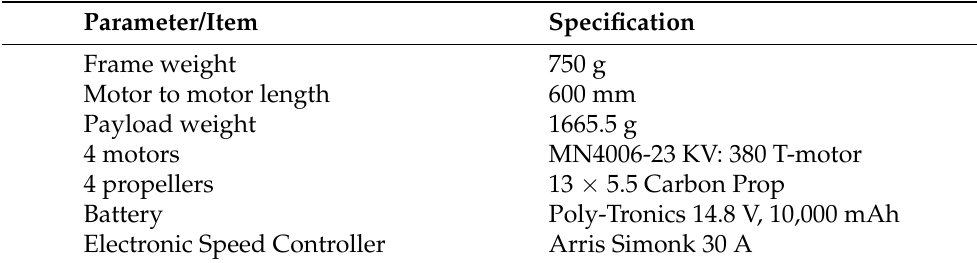
Table 2. Tarot quadcopter components specifications.